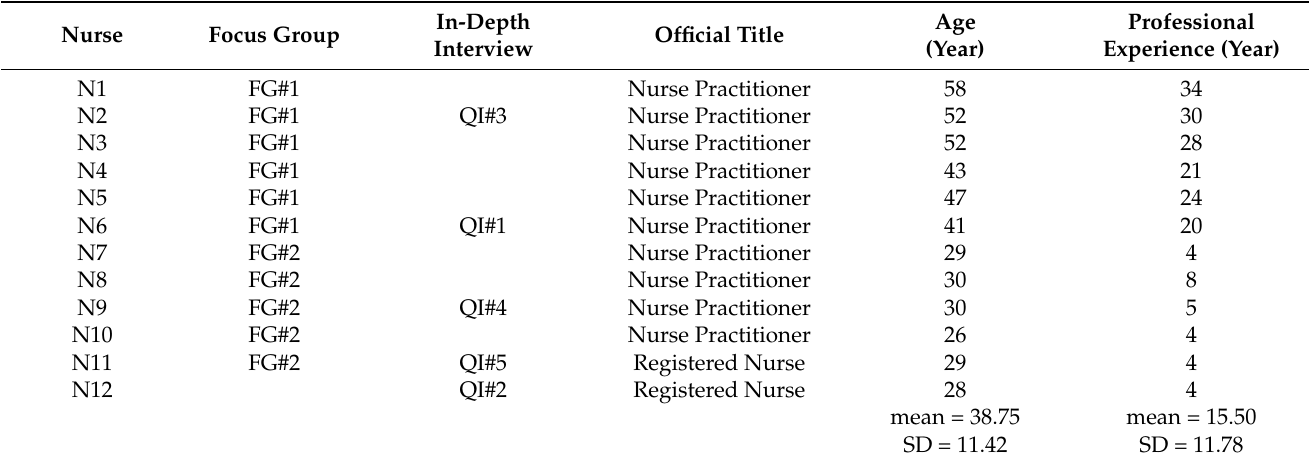
Table 1. Demographic characteristics of the